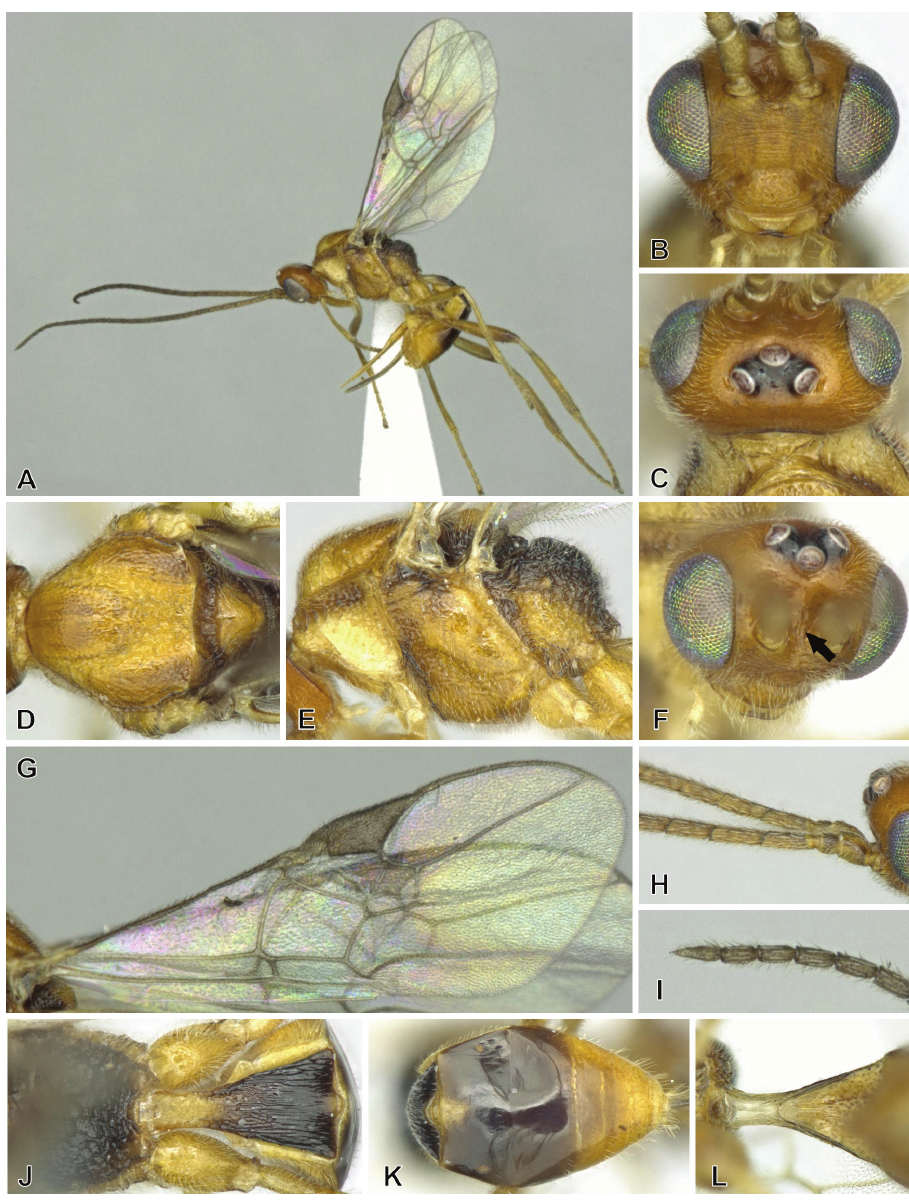
Figure 2. Meteorus stellatus sp. nov., ♀ holotype (exceptionally L is a paratype) A habitus B head, frontal view C head, dorsal view D mesopleuron and scutellum, dorsal view E mesosoma, lateral view F head, dorso-lateral view G forewing H basal antennal segments I apical antennal segments J propodeum and T1, dorsal view K T2 and following tergites, dorsal view L T1, ventral